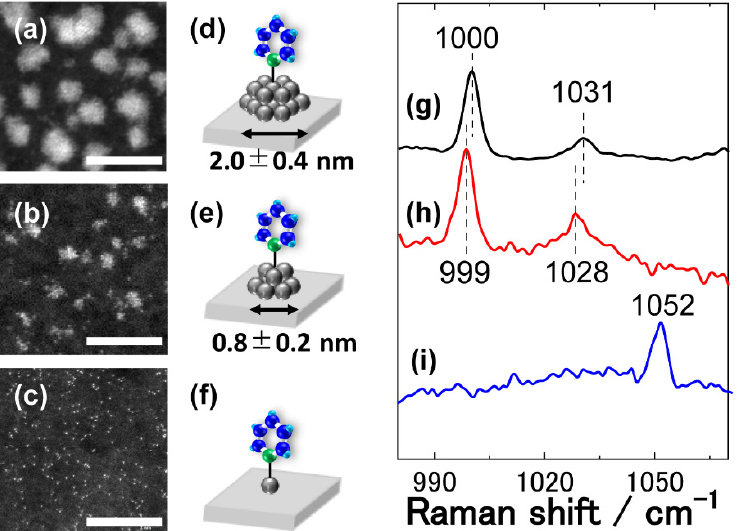
Figure 4. Raman studies for the Py molecules on the Pt subnano-islands and Pt single-atoms with shell-isolated Au nanostars. ( a – c ) TEM images of Pt subnano-islands prepared by APD (scale bar: 5 nm), ( d – f ) schematic images and ( g – i ) SHINER spectra of Py molecules adsorbed on the Pt islands and atoms. Pt subnano-islands were prepared by ( a , d , g ) 100, ( b , e , h ) 10 and ( c , f , i ) 1 APD pulses, respectively. The former two samples had the average sizes of ( a ) 2.0 ± 0.4 and ( b ) 0.8 ± 0.2 nm, respectively, while the latter sample gave individually deposited atoms on the HOPG surface.